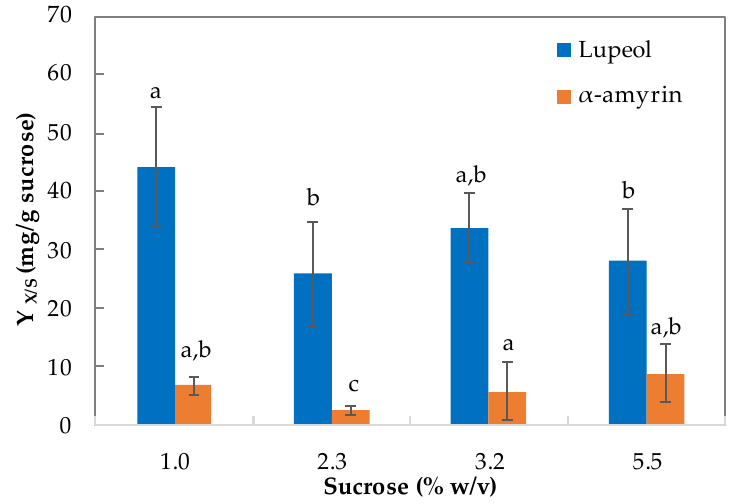
Figure 7. Yields (on substrate) for α -amyrin and lupeol in suspension cultures of T. officinale. (Basal MS medium, sucrose 1.0%, 2.3%, 3.2%, and 5.5% ( w / v ), 3.0 mg/L NAA, 3.0 mg/L BAP, pH 5.8, 18 ± 2 °C, 0/24 h light/dark. 8th week of culture). Means with the same letter above the bars were not significantly different at the 0.05 level according to the DMRT test. Bars indicate standard error.